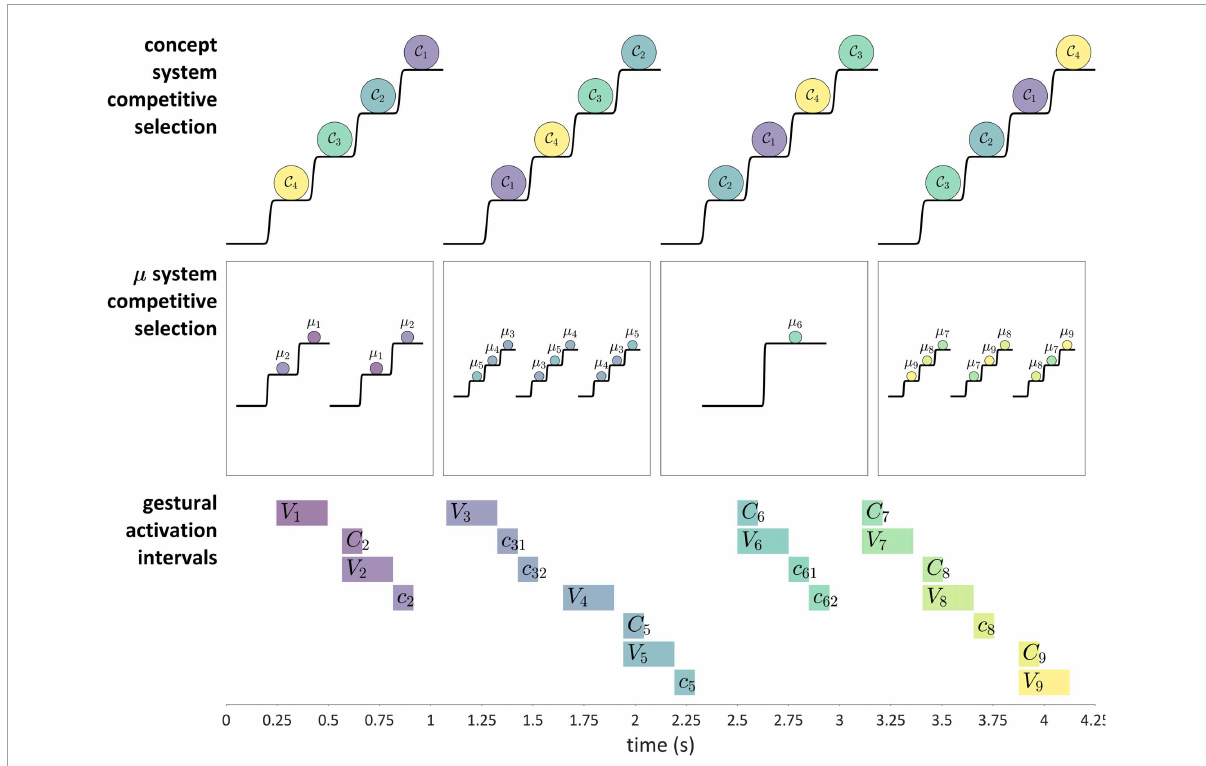
FIGURE12 Illustration of parallel domains of competitive selection for an utterance with the structure. (Top) Concept systems C are competitive selected. (Middle) Selection a concept system de-gates corresponding µ -systems which themselves are competitively selected. (Bottom) Gestural activation intervals generated by the